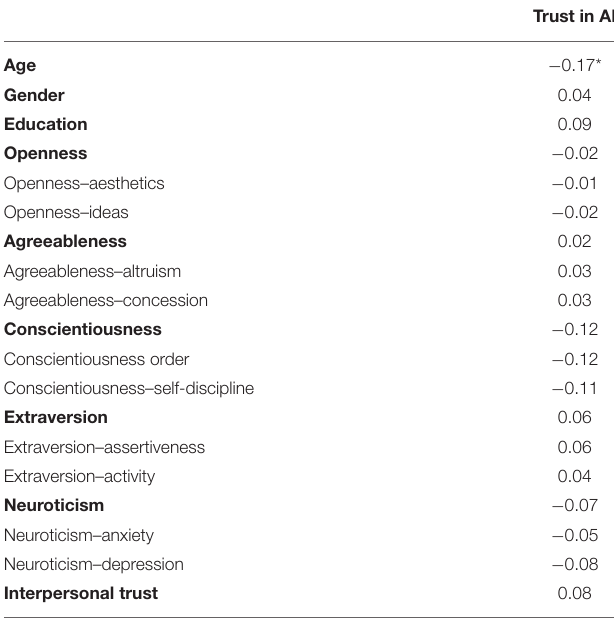
TABLE 1 | Correlations between sociodemographic data, Big 5 traits and facets, interpersonal trust, and general trust in